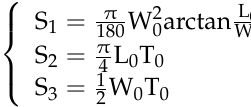
Table 1. Three-dimensional sizes of